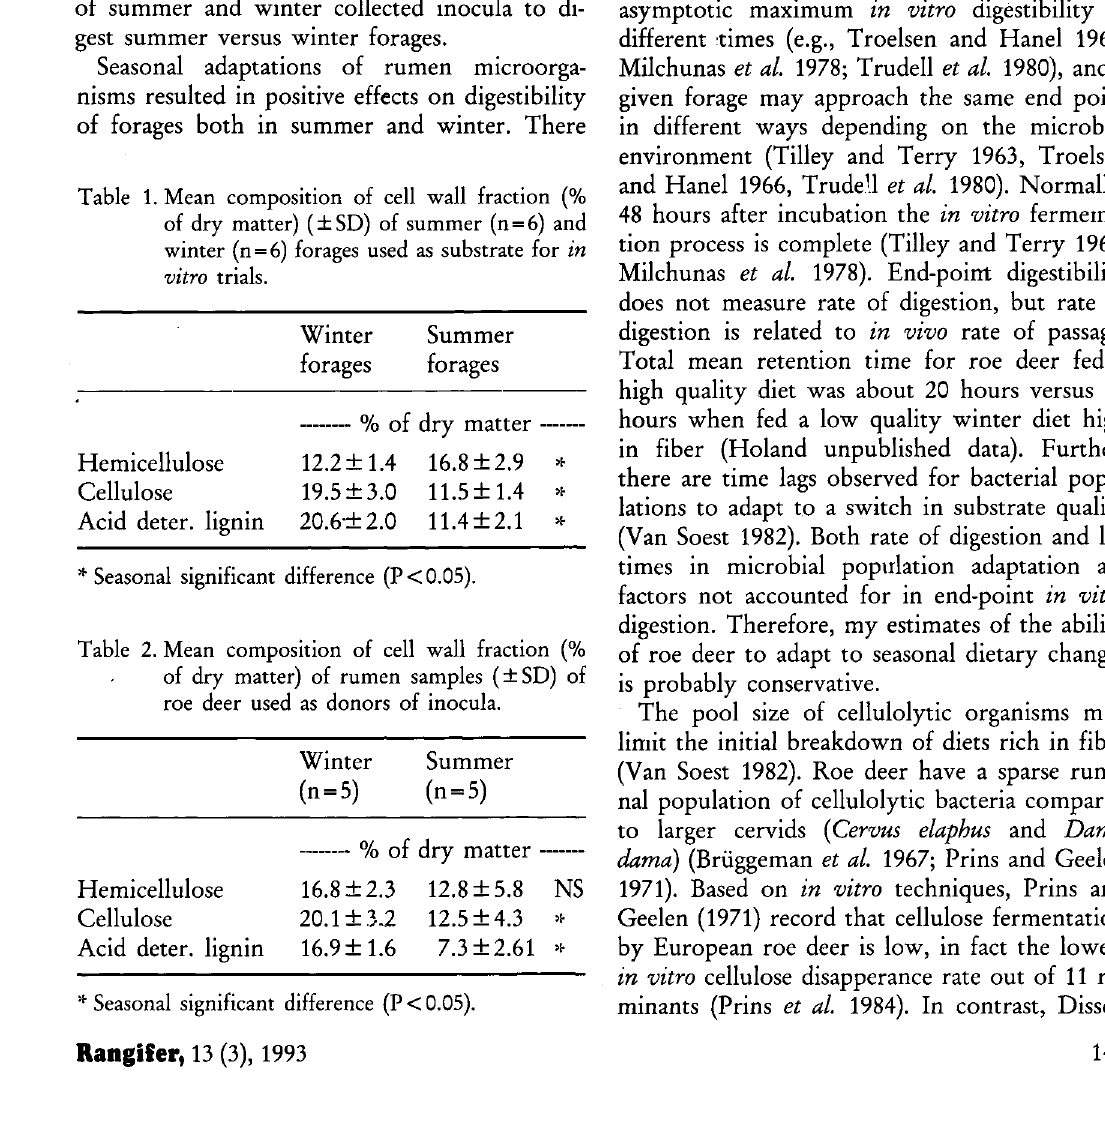
Table 1. Mean composition of cell wall fraction (% of dry matter) (±SD) of summer (n = 6) and winter (n = 6) forages used as substrate for in vitro trials.